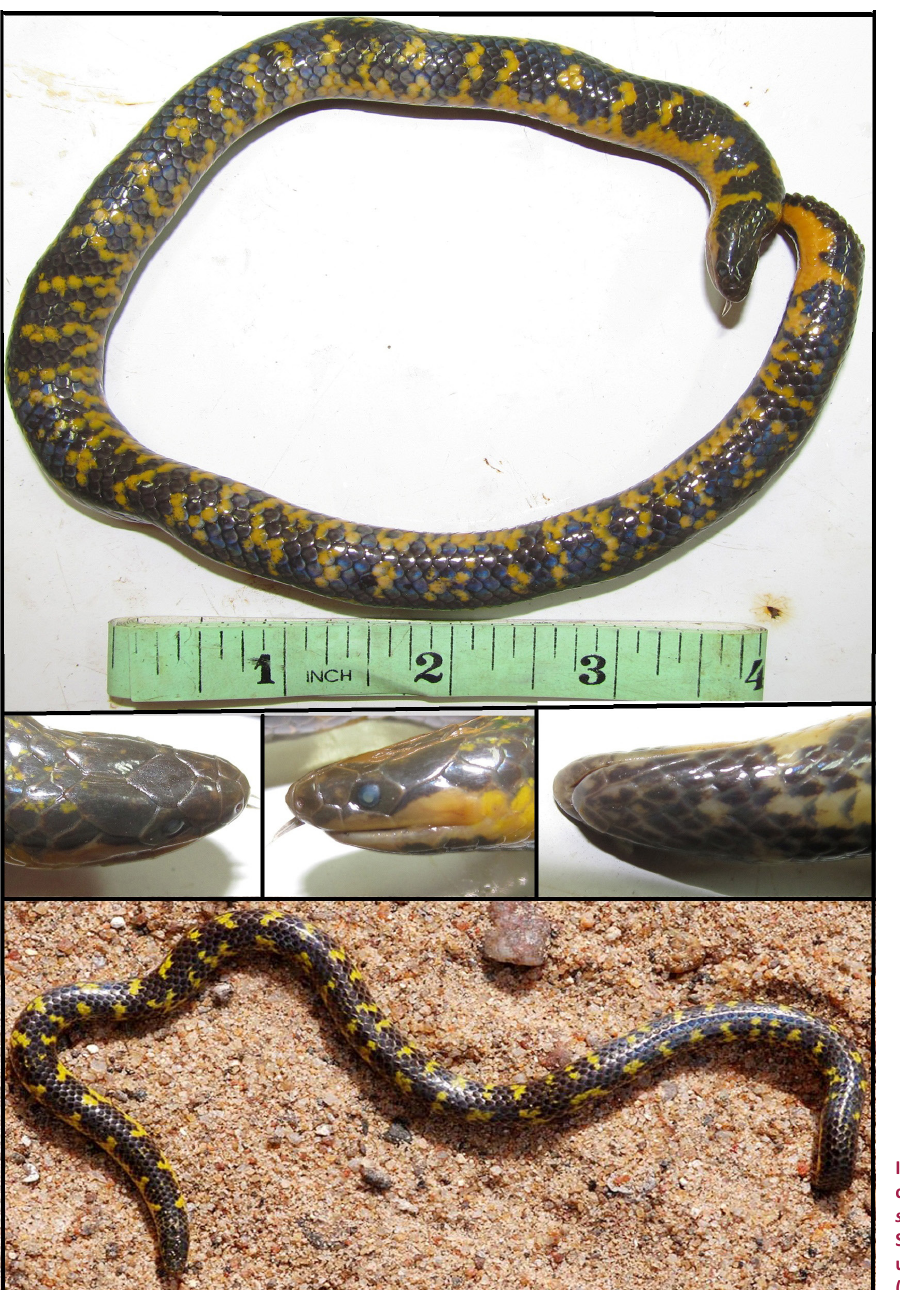
than parietal; parietals large, largest of all head scales; supralabials 4,4 (left, right), 1 st and 2 nd ones small, 3 rd below eye, 4 th the largest; infralabials 3,3 (left, right), elongate; mental scale small, subequal to 1 st infralabial, but as wide as long; body scales imbricate, cycloid; dorsally around body in 19 (one head length after neck): 17 (at midbody): 17–15 (one head length before vent) rows; ventrals 141–156 (148.5±10.6), angulate laterally; anals 2, left overlapping right, each larger than a body